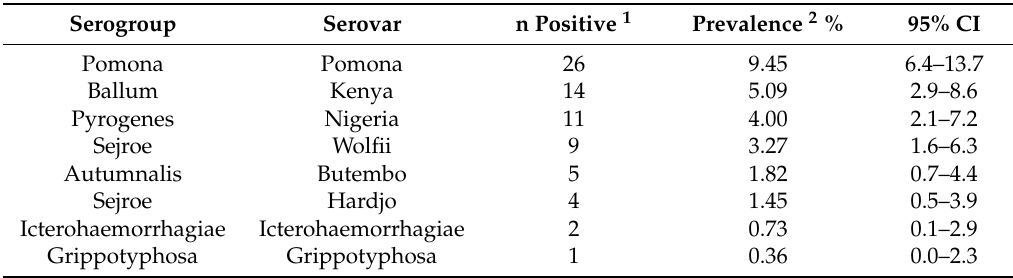
Table 2. Seroprevalence of Leptospira serovars and serogroups by Microscopic Agglutination Test (titer ≥ 1:100) among 275 bovines sampled in Kole and Mbale district, Uganda. Serogroup Serovar n Positive 1 Prevalence 2 % 95% CI Pomona Pomona